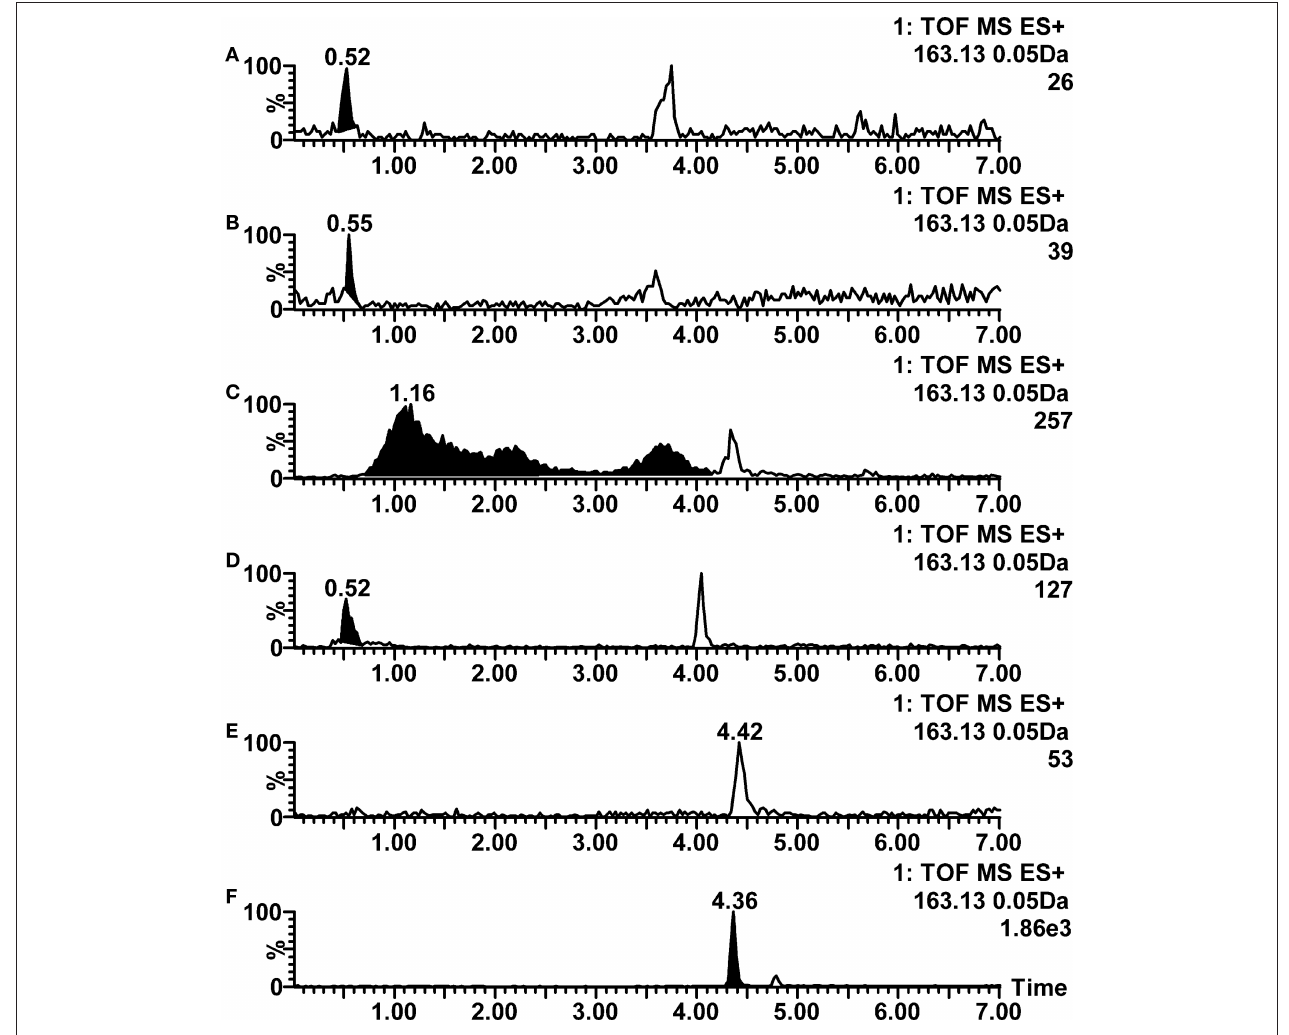
FIgurE 5 | Positive ion mode LC–ESI–TOF–MS ion chromatograms for nicotine at various mobile phase pH conditions. (A) 0.1% formic acid (pH 2.8); (B) 0.1% acetic acid (pH 3.2); (C) 2 mM ammonium formate (pH 6.0);